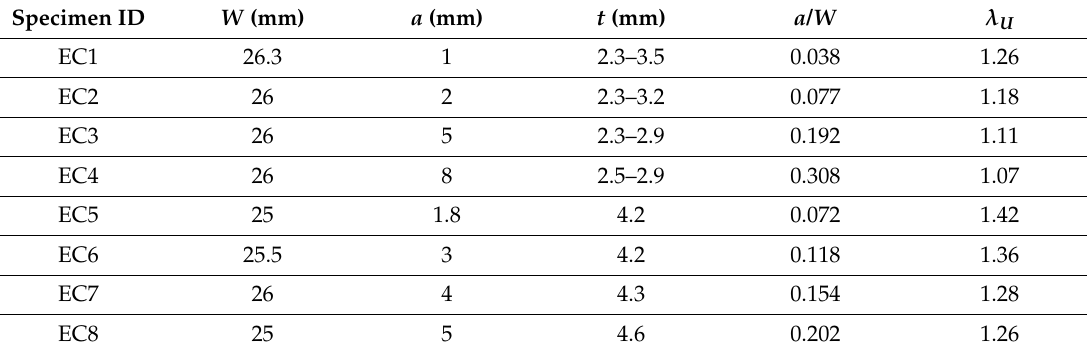
Table 3. Geometric characteristics of the edge-cracked plates. The rightmost column contains the ultimate remote stretch before failure. In specimens EC1–EC4, the fastest rate is considered.